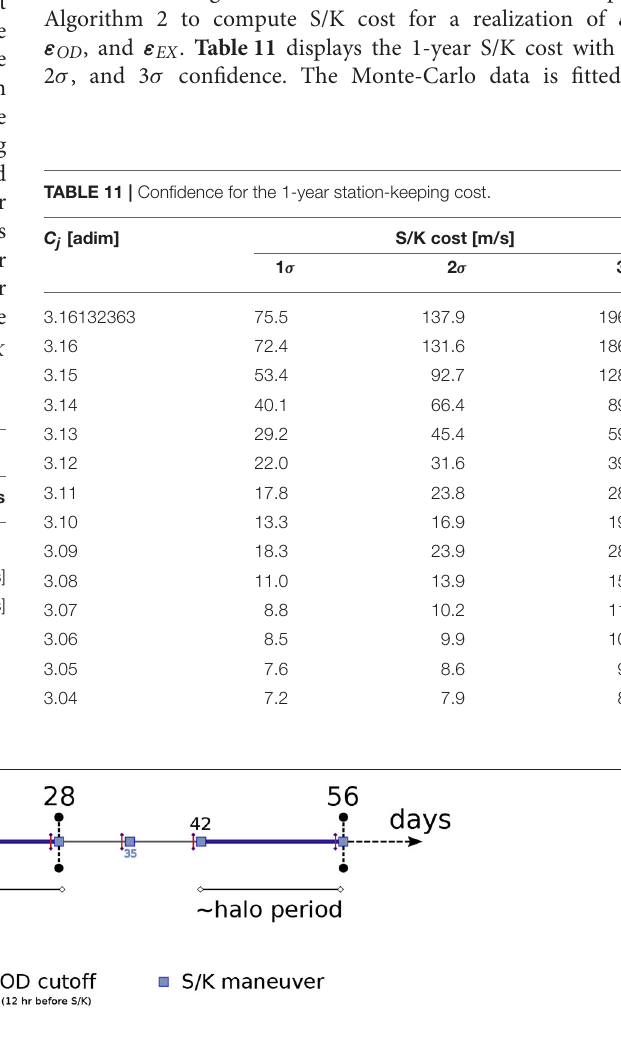
Algorithm 2 to compute S/K cost for a realization of ε OI ,